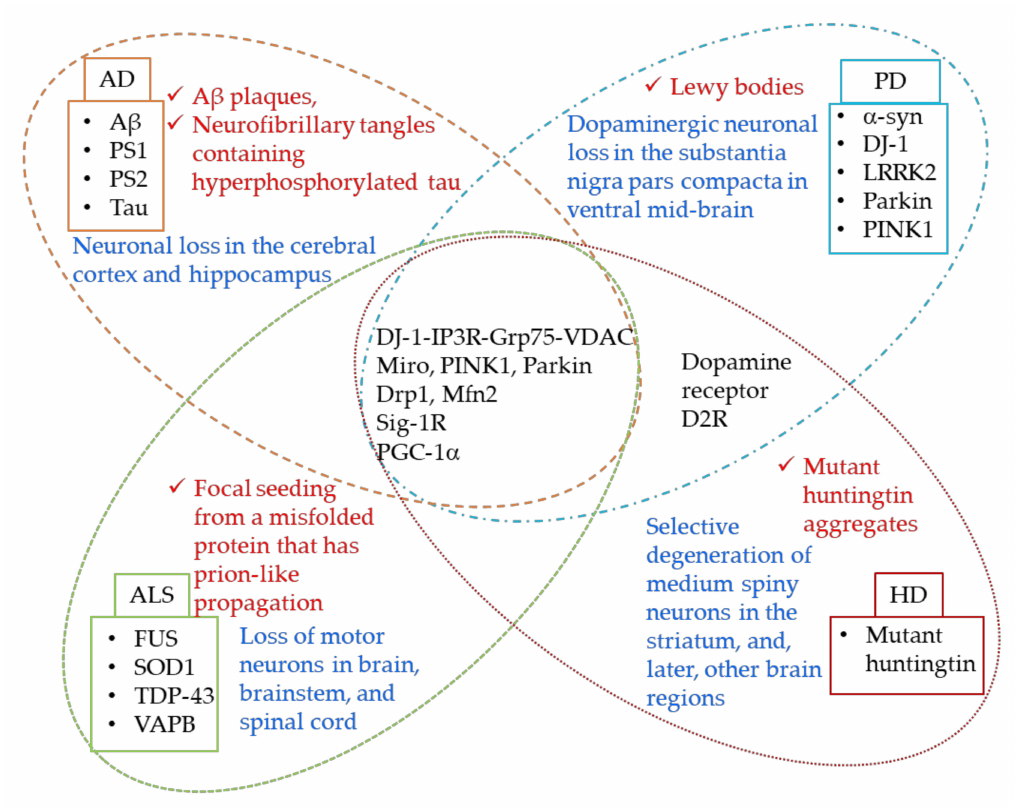
Figure 5. Although certain factors are different, there are significant overlaps between AD, PD, HD, and ALS when it comes to ER–MAM–mitochondria interactions. Apart from obvious endgame similarities i.e., Ca 2+ dyshomeostasis, ETC complex disturbances, increased fission/fusion, mitophagy, antioxidant depletion, ROS, ER stress and apoptosis, and reduced mitochondrial movement, mechanistic commonalities include alterations in the following: 1. DJ-1-IP3R-Grp75-VDAC tetrameric complex. DJ-1 interacts with IP3R-Grp75-VDAC and is an essential part of the complex. The release of Ca 2+ from ER is mediated via this complex; 2. Sig-1R, IP3R, D2R interactions. Sig-1R interacts with Dopamine receptors and regulates plasticity mechanisms; 3. Miro, PINK1, Parkin, and Mfn2 together regulate mitophagy and ER–mitochondria connections; 4. PGC-1 α is altered in all these diseases and interacts with both Parkin and Mfn2, thus it is logical to speculate a role of this important cofactor at the MAMs. Proteins mutated in each of the diseases are shown in their respective boxes. Neuropathological hallmarks of each disease are given in red, while the selective neuronal population affected is shown in